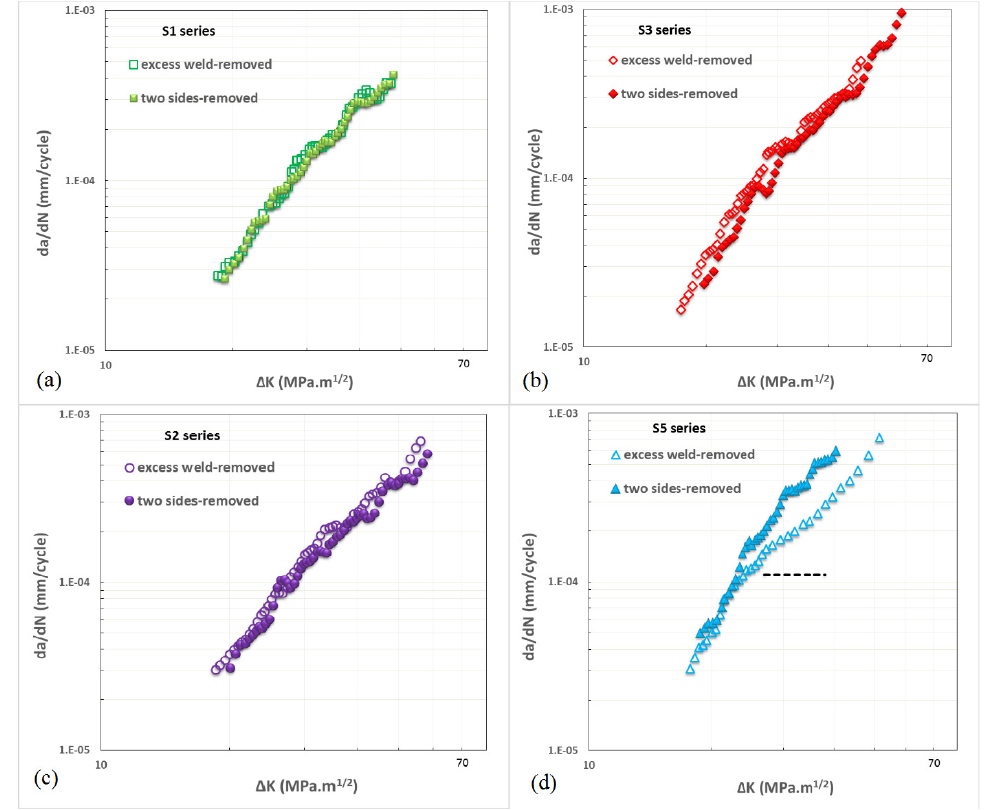
Figure 6. Fatigue crack growth rate at Paris regime for series ( a ) S1, ( b ) S3, ( c ) S2 and ( d )